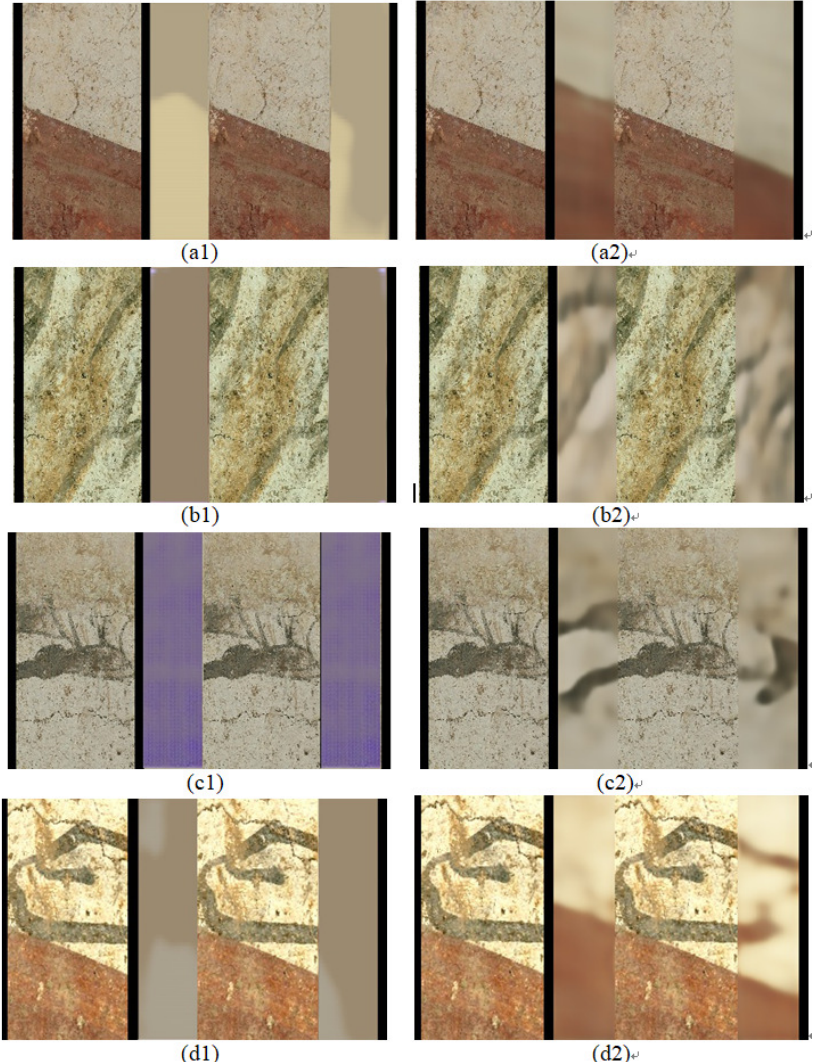
Fig. 10 The comparisons of information extension